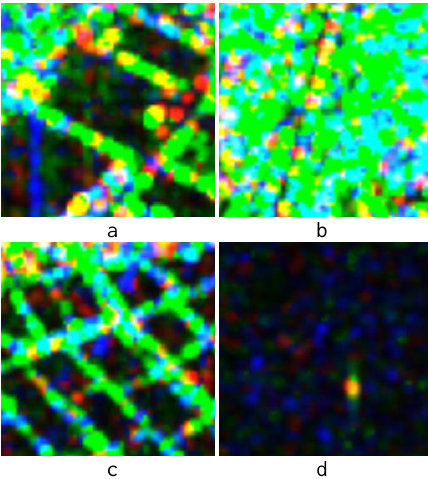
Figure 5. Sample diagram of 2m resolution. a)Building,